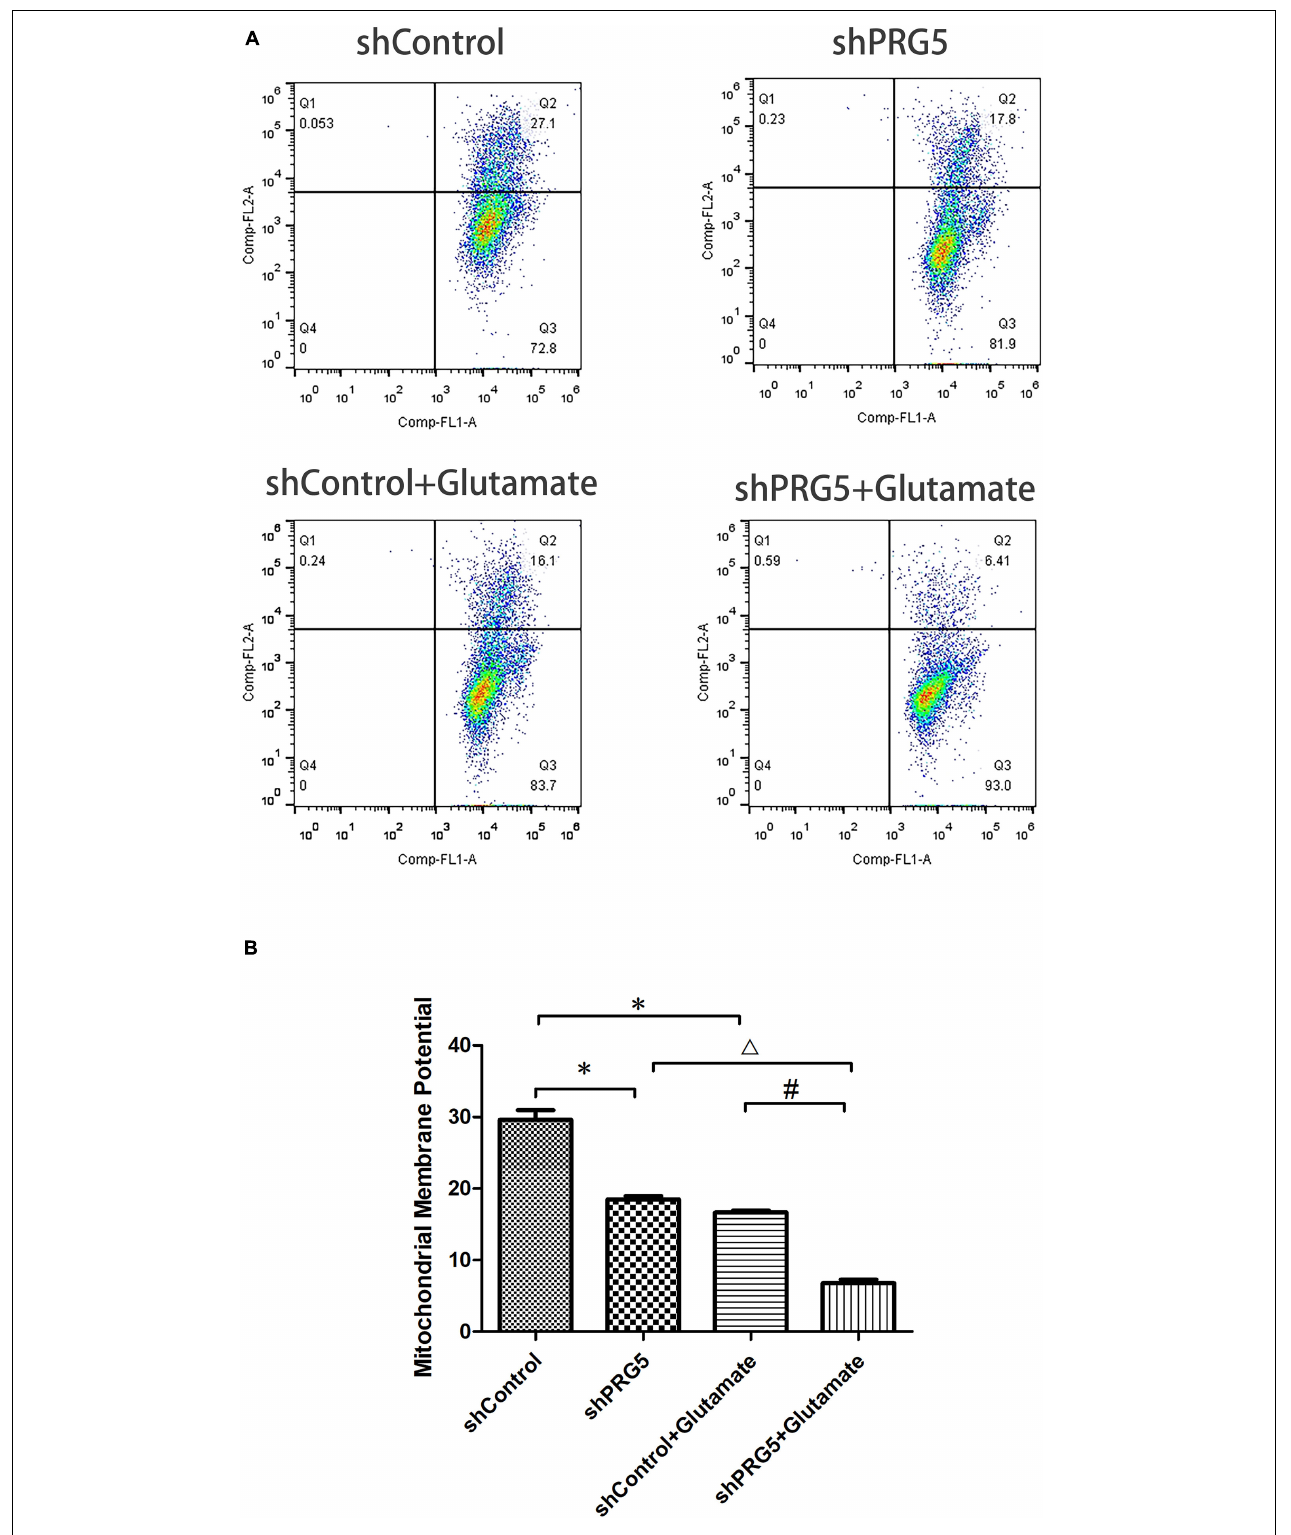
FIGURE 5 | The effect of PRG5 gene silencing and glutamate treatment on the changes of mitochondrial membrane potential by JC-1. (A) Flow cytometric diagram of cell mitochondrial membrane potential in each group. (B) Analysis of cell mitochondrial membrane potential in each group. ∗ P < 0.05 compared with shControl group, (cid:77) P < 0.05 compared with shPRG5 group, # P < 0.05 compared with Control + Glutamate group ( n = 3).